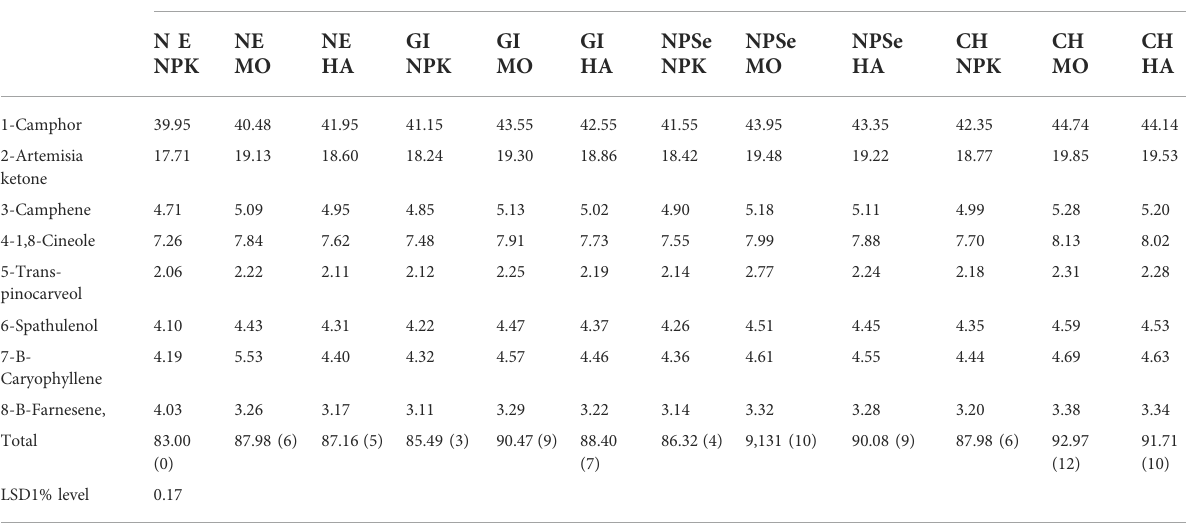
TABLE 3 Artemisia essential oil content, mono terpene (MT), and sesquiterpene (ST) in response to gamma irradiation (GI) nano-selenium oxide (NP), chitosan (CH) integrated with (NPK), Moringa (MO) and humic acid fertilizers. EO